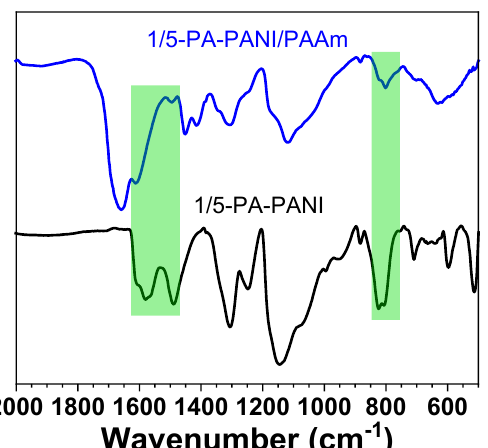
Figure 2. FTIR spectra of PA-PANI and 1/5-PA-PANI/PAAm cryogels.